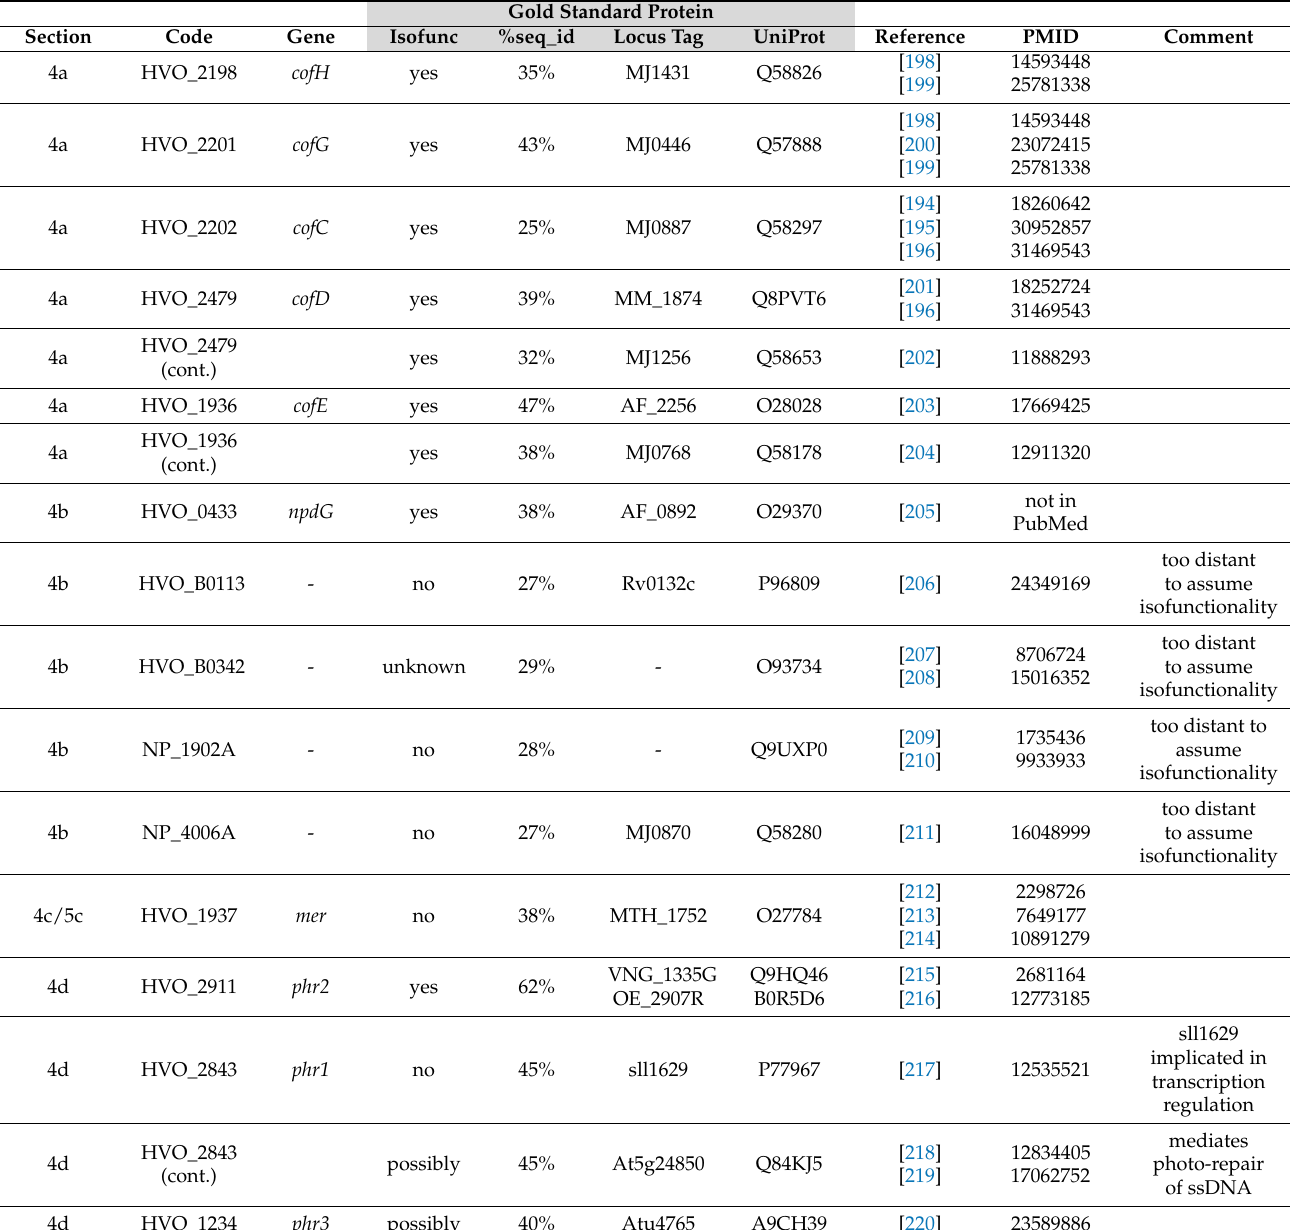
Table 4. Proteins with open annotation issues and their Gold Standard Protein homologs (Section 3.4). For a description of this table, see the legend to Table